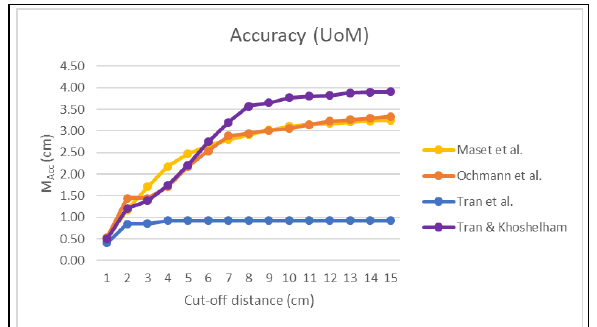
Figure 5. Accuracy of submitted models for UoM